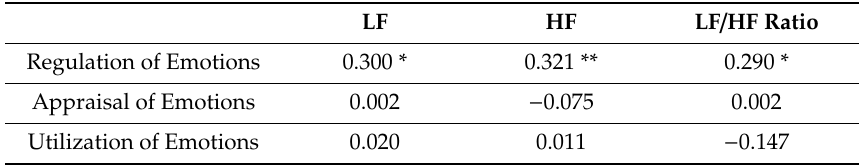
Table 1. The relationship among trait emotional intelligence and heart rate variability (HRV). LF: low frequency; HF: high frequency. LF HF LF / HF Ratio Regulation of Emotions 0.300 * 0.321 ** 0.290 * Appraisal of Emotions 0.002 − 0.075 0.002 Utilization of Emotions 0.020 0.011 − 0.147